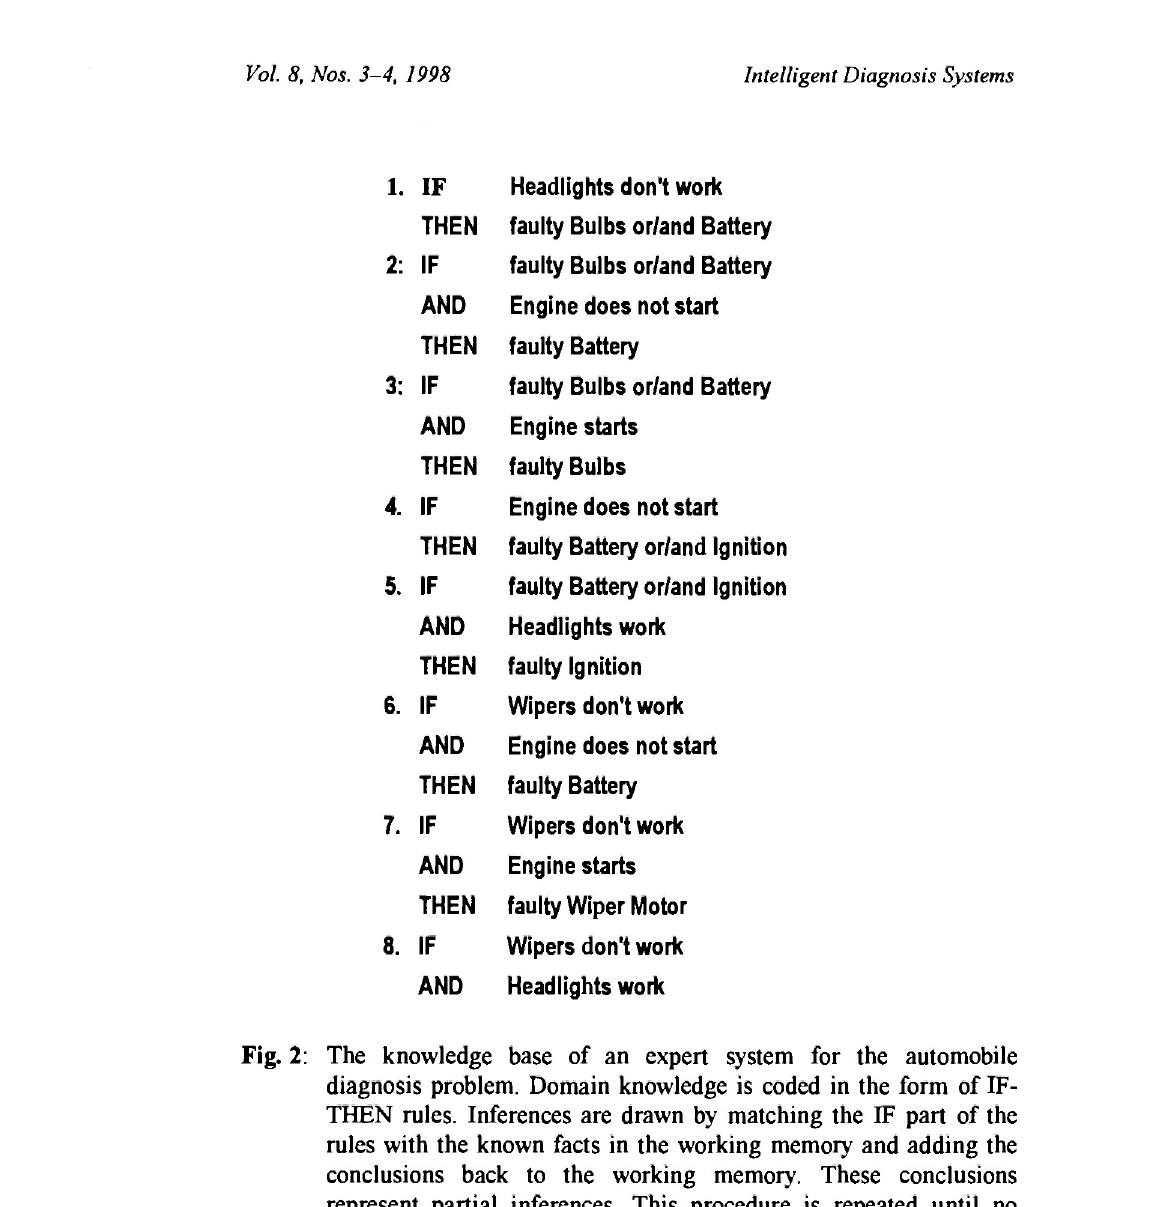
Fig. 2: The knowledge base of an expert system for the automobile diagnosis problem. Domain knowledge is coded in the form of IF- THEN rules. Inferences are drawn by matching the IF part of the rules with the known facts in the working memory and adding the conclusions back to the working memory. These conclusions represent partial inferences. This procedure is repeated until no further rules match the inferences in the working